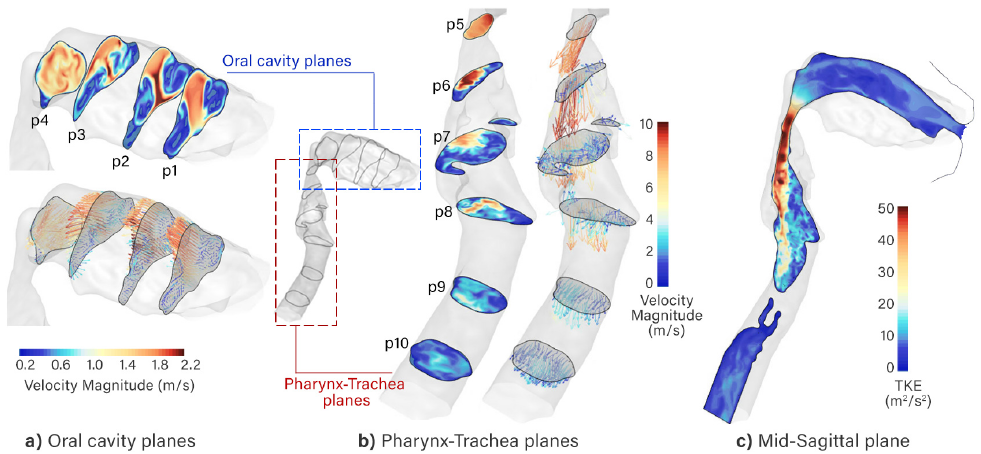
Figure 1. ( a ) Velocity contours at coronal planes where the velocity color range is 0 to 2.2 m/s. ( b ) Velocity contours of sagittal plane where the velocity color range is 0 to 10 m/s. ( c ) Turbulent kinetic energy contour in the mid-sagittal